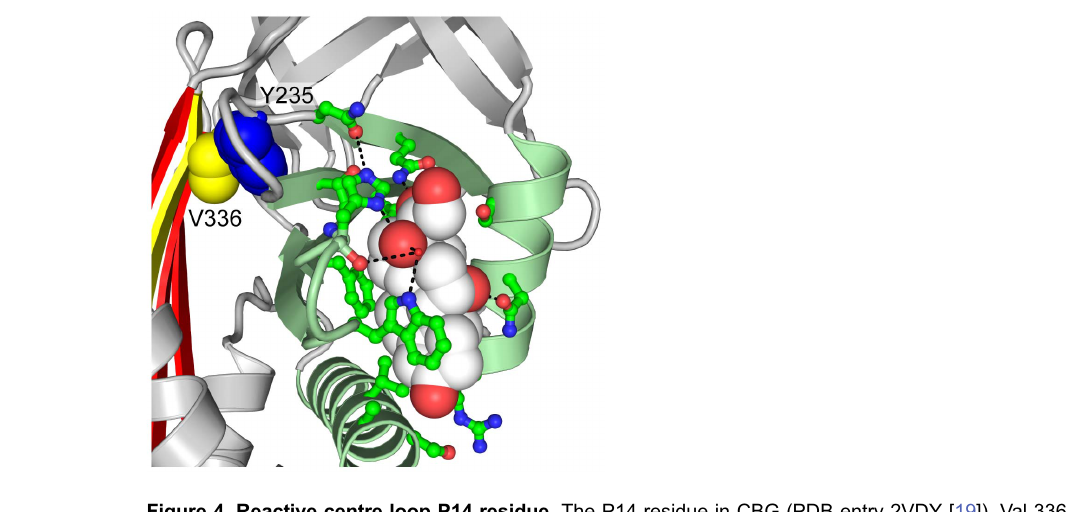
Table 2. Comparing the changes in cortisol binding affinity of CBG mutants.